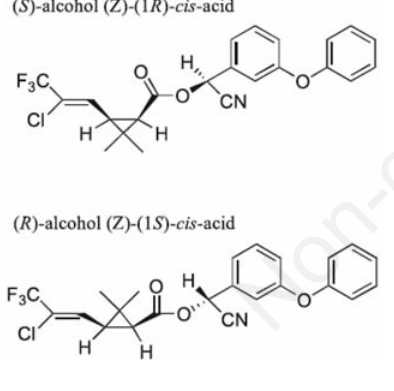
Figure 1. Chemical structure of lambda- cyhalothrin.